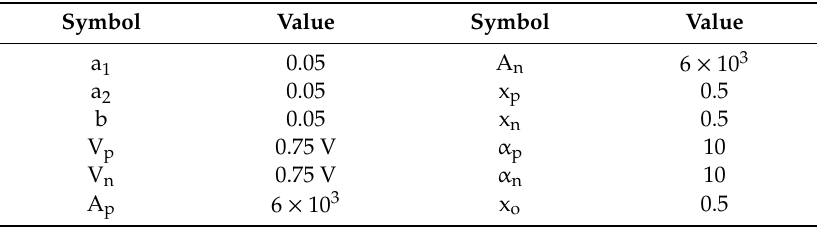
Table 1. Memristor device modeling parameters.